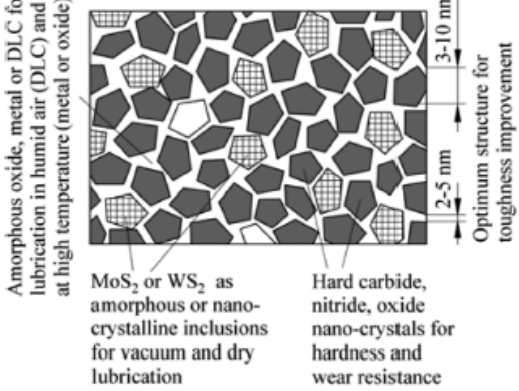
Figure 7: Conceptual design schematic of self surface